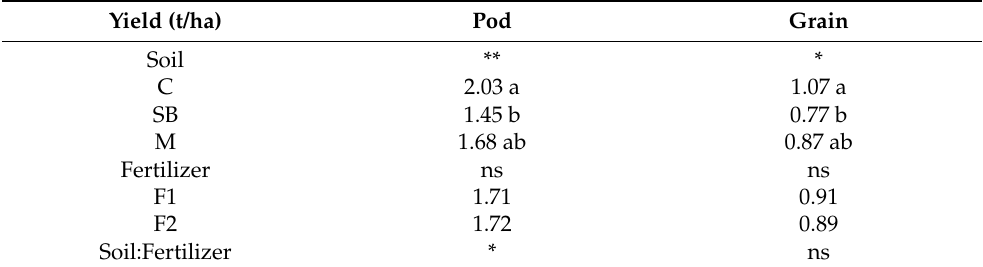
Table 3. Effects of soil organic amendment and fertilizer placement on pod and peanut grain yield